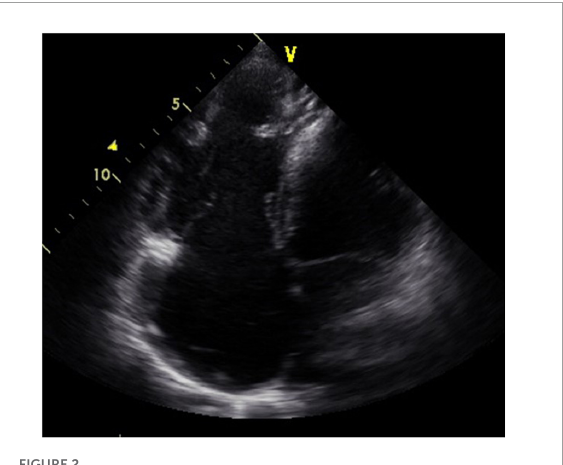
FIGURE2 Four-chamber view at end-systolic phase of transthoracic echocardiography in Case 1. Note that the tricuspid valve does not close at all, and the right atrium is hugely dilated.